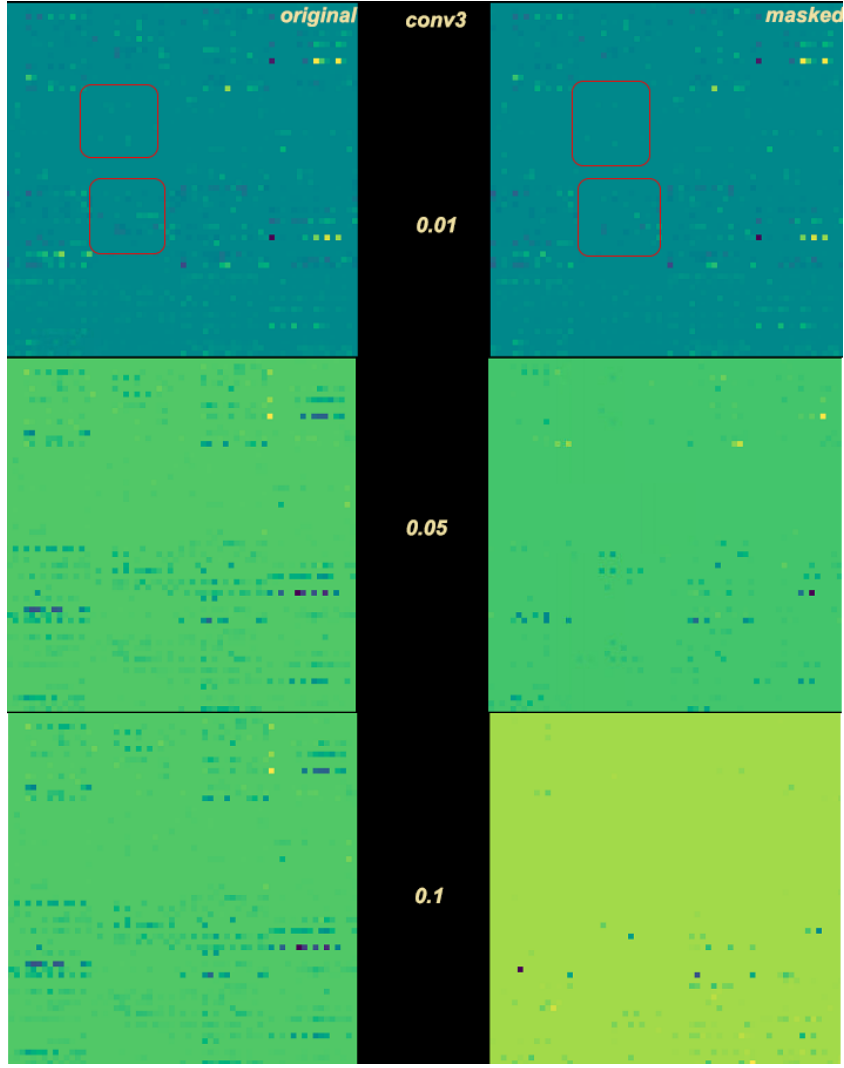
Figure 3. Threshold effect on the third convolution filter, for p = 0.01, p = 0.05, and p = 0.1. Red squares in the first dense example indicate same pixel neighborhoods for easier